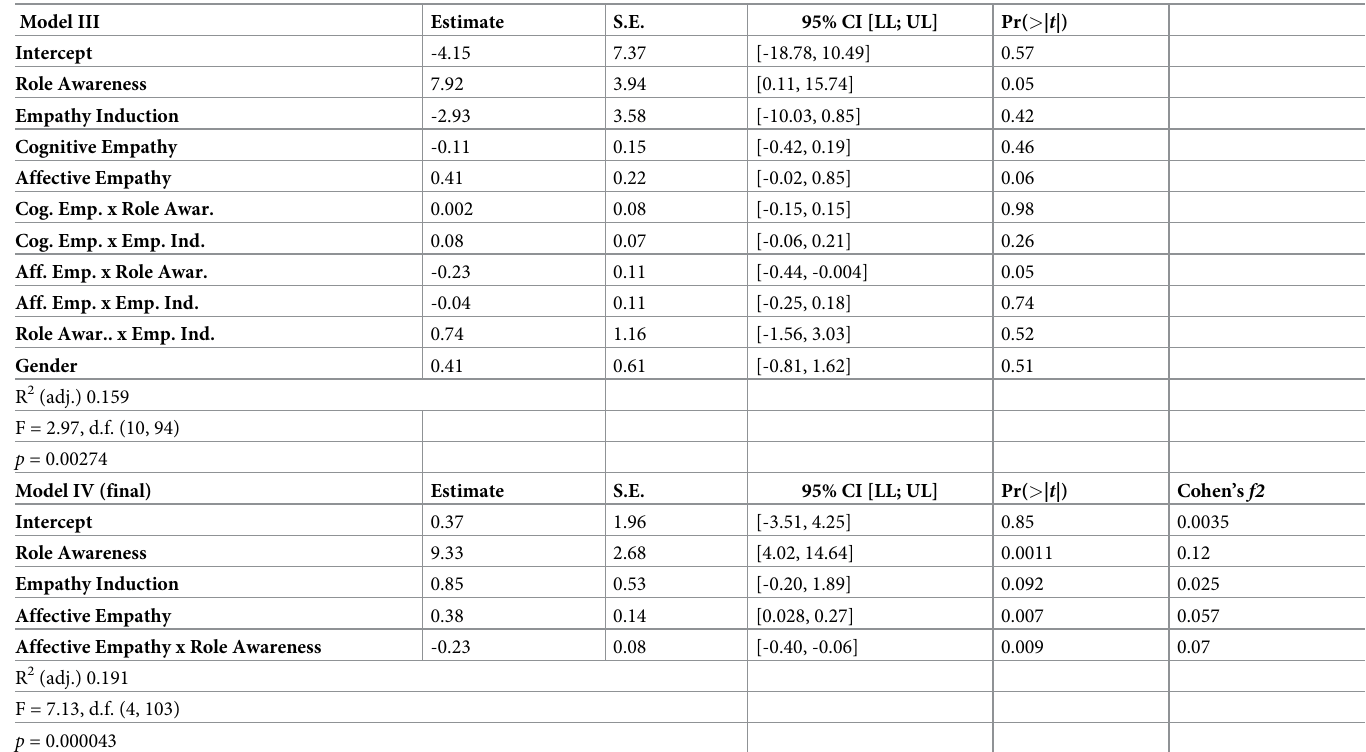
Table 6. Regression results of dictator game giving, QCAE subscales as